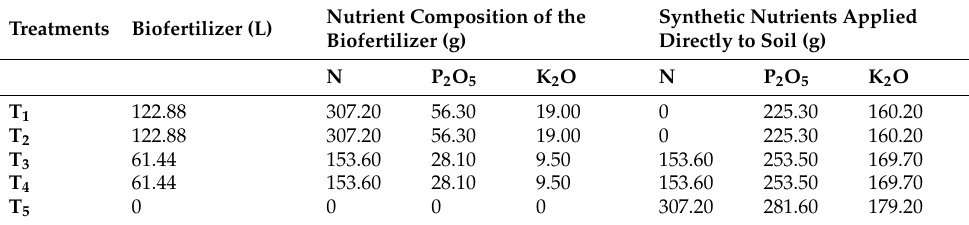
synthetic fertilizers Mineral fertilization as recommended for the In-row broadcasting maize crop in the Paran á State of Brazil Table 4. Nutrient composition and application rates (L Plot − 1 ) for the different fertilization treatments. Nutrient Composition of the Synthetic Nutrients Applied Treatments Biofertilizer (L) Biofertilizer (g) Directly to Soil